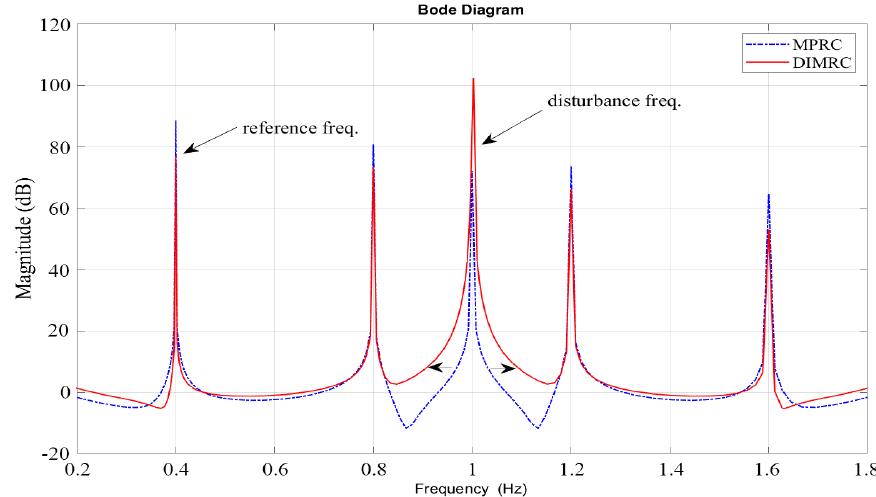
Figure 9. Tracking errors for the minimum phase system (30) with the disturbance model v 2 ( t ) .